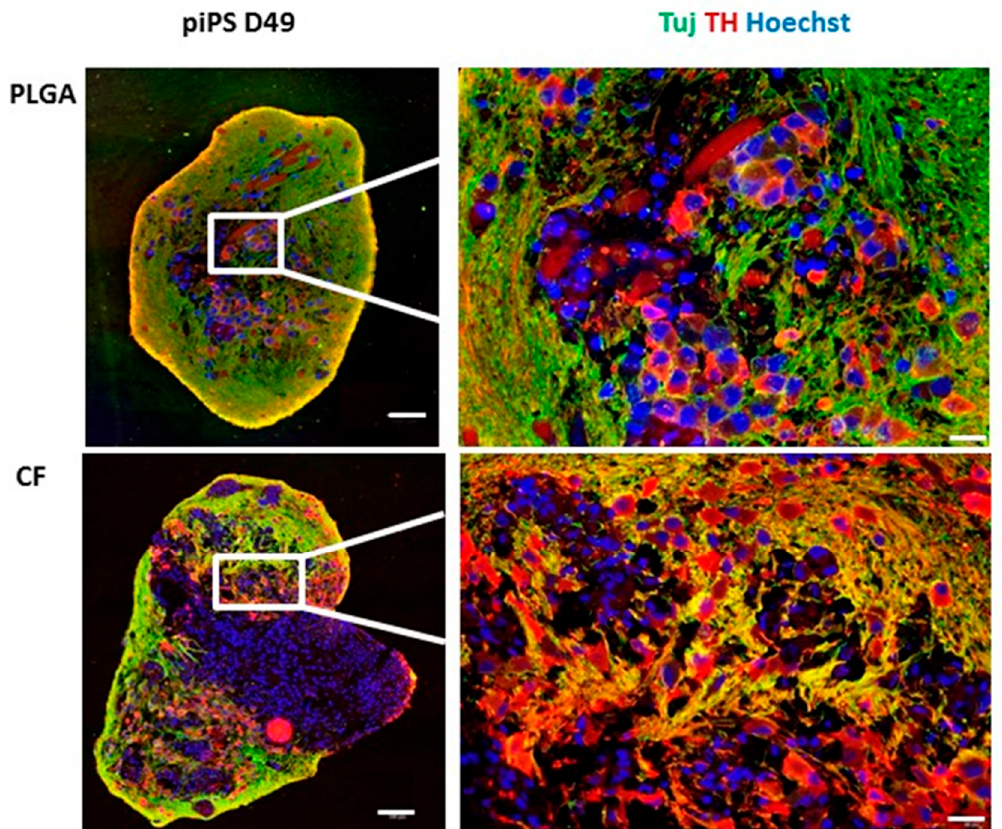
Figure 6. Immunofluorescent characteristics of the organoids. piPSC PLGA and piPSC CF at day 49 (D49) were collected, fixed in 4% PFA, and then embedded in paraffin blocks and stained with neuron-specific class III β -tubulin (TUJ1), tyrosine hydroxylase (TH), the characteristic marker of mDA neurons, and nuclear marker Hoechst 33342. White scale bar 100 µ m (whole organoid, left side of the panel) or 20 µ m (fragment of organoid, right side of the panel).